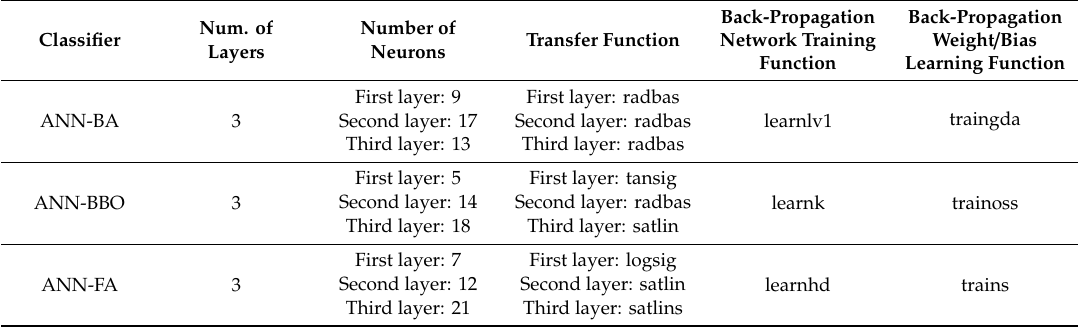
Table 2. The best structure of hidden layers of the artificial neural network (ANN) adjusted by bees algorithm (BA), biogeography-based optimization (BBO) and firefly algorithm (FA).